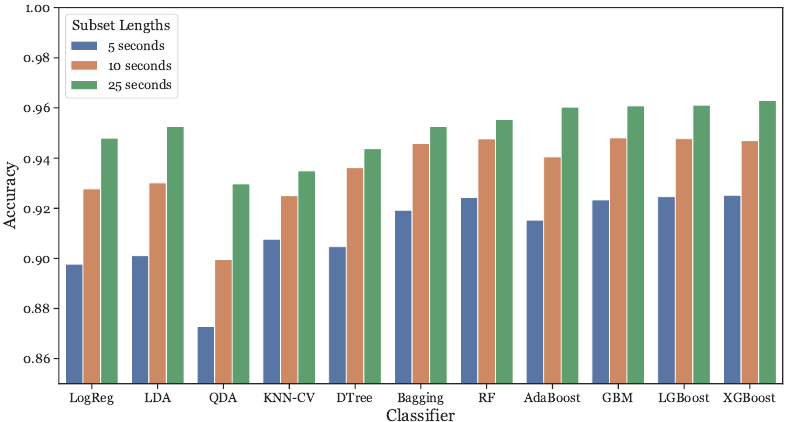
Figure 10. Accuracies across all subset lengths (5, 10, and 25 s) using LOOCV.